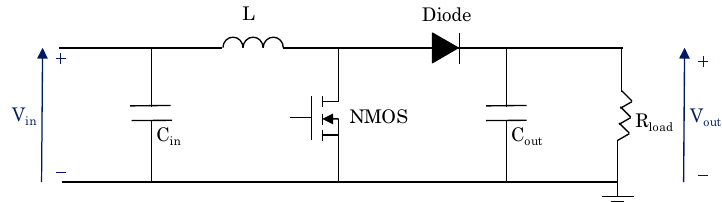
Figure 9. DC/DC boost architecture for the photovoltaic module converter.